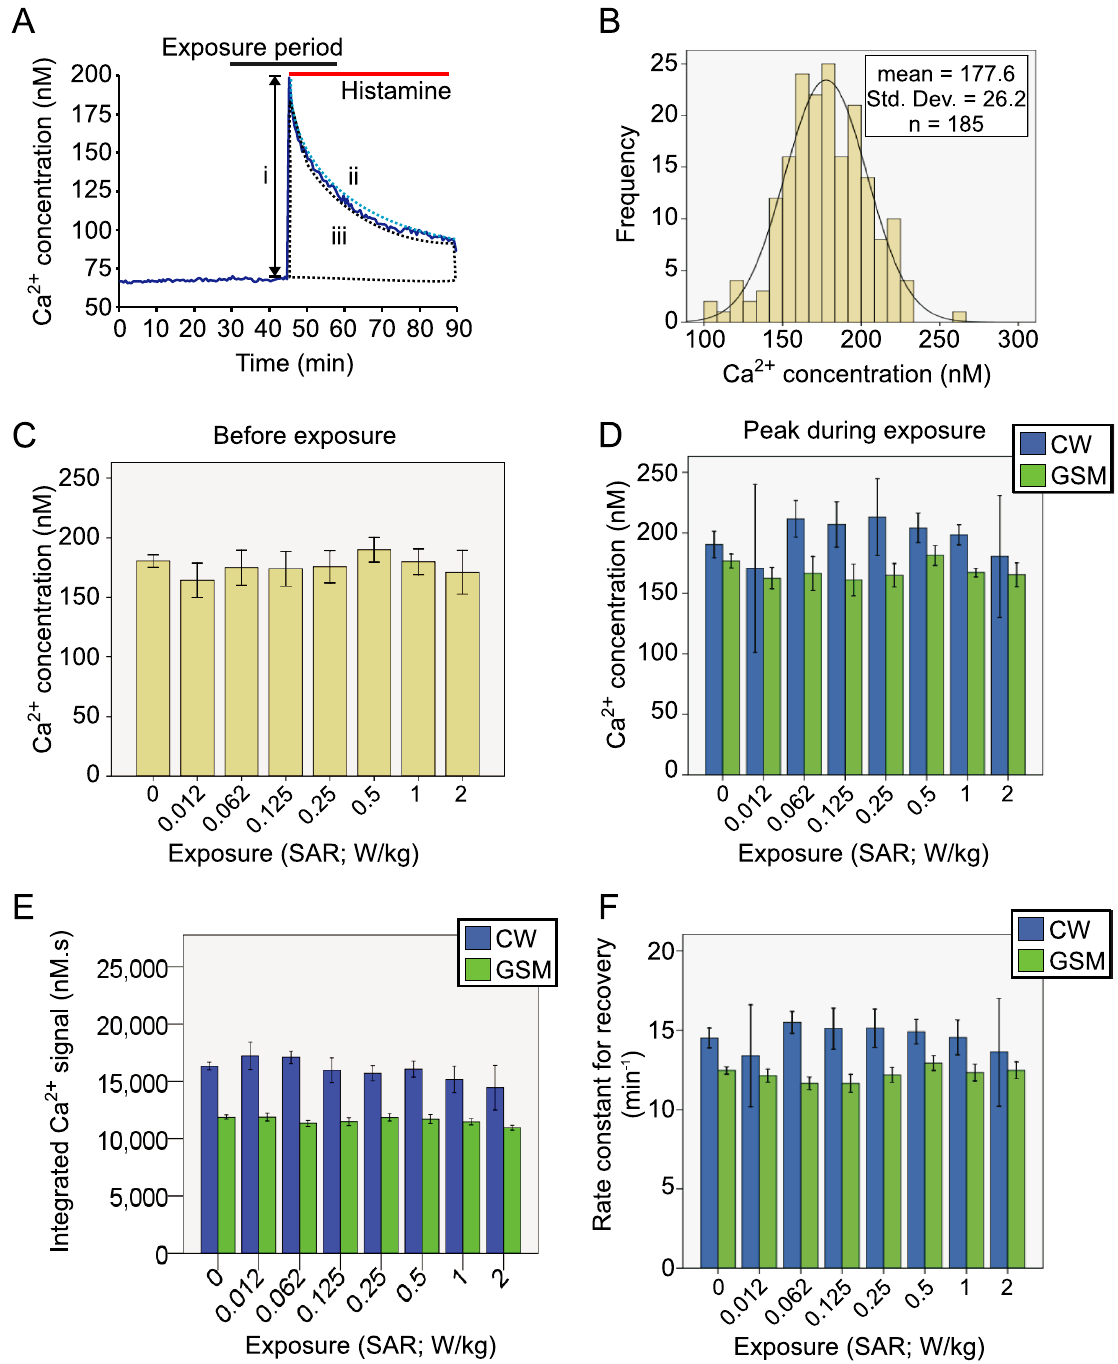
Figure 5. Effect of RF exposure on Histamine-Induced Ca 2 + Release. A ; Sample trace showing the experimental protocol. Cytosolic Ca 2 + - release induced by histamine was measured in EA.hy926 cells exposed to 900 MHz RF fields at 7 levels of SAR using either GSM-modulated or continuous wave (CW) power. The peak Ca 2 + -release ( i ), time constant for recovery of the Ca 2 + signal ( ii ) and integrated Ca 2 + response (area under the Ca 2 + curve) ( iii ) was quantified for each cell imaged. B ; cytosolic Ca 2 + -release was normally distributed, permitting the use of parametric statistical tools (Kolmogorov-Smirnov Z=0.81, p=.54, tested against a normal distribution). C ; main effect. When GSM and CW exposures were pooled, no significant difference was observed in the peak Ca 2 + release of cells exposed to either of the 7 SARs during the 30-minute exposure period, (F(7,184)=1.10, p=.37). D ; considered individually, there were no significant differences in Ca 2 + release in either the GSM (F(7,135)=1.78, p=.10) or CW conditions (F(7,50)=1.06, p=0.41). E ; No significant differences were observed in the integrated Ca 2 + signal between control and exposed coverslides at any of the SARs tested in either CW or GSM modulation. (all F , 1, p . .10). F ; no significant differences were observed in the recovery of the Ca 2 + signals at any of the SARs in either CW or GSM exposed samples (all F , 1, n.s.). Repeated measures failed Mauchly’s test, therefore Greenhouse-Geiser corrected statistics were used.